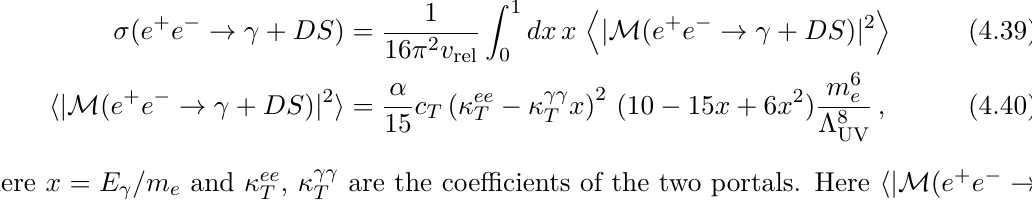
F µ F αν (diagram µν α